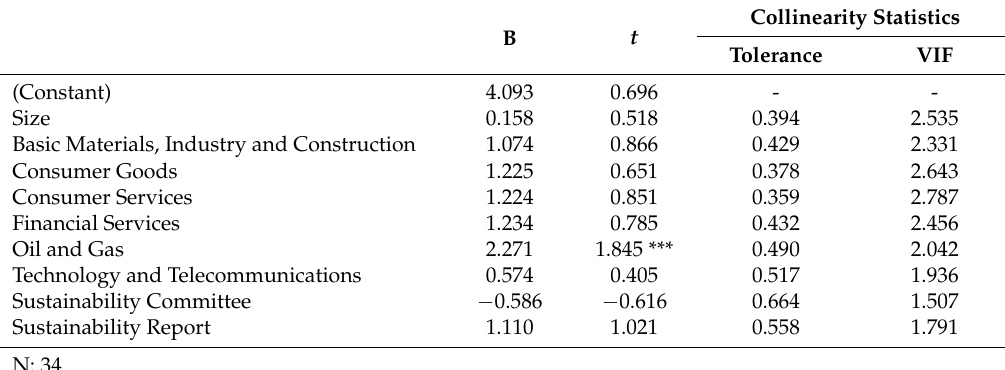
Table 11. Employment Matters Index as Dependent